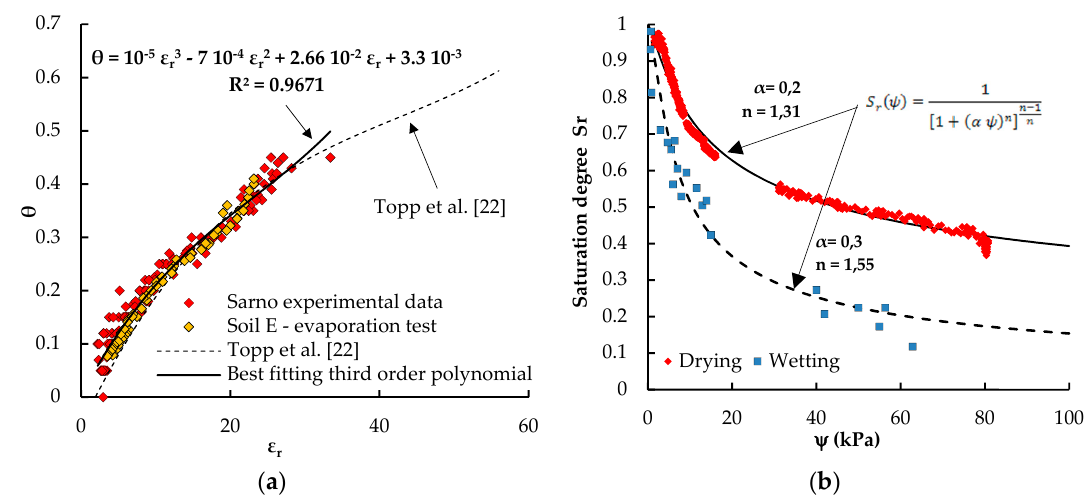
Figure 9. ( a ) Experimental calibration curve that couples volumetric water content with soil relative dielectric constant; and ( b ) drying and wetting soil water retention curve, fitted by Van Genuchten equation (hp. θ r = 0).